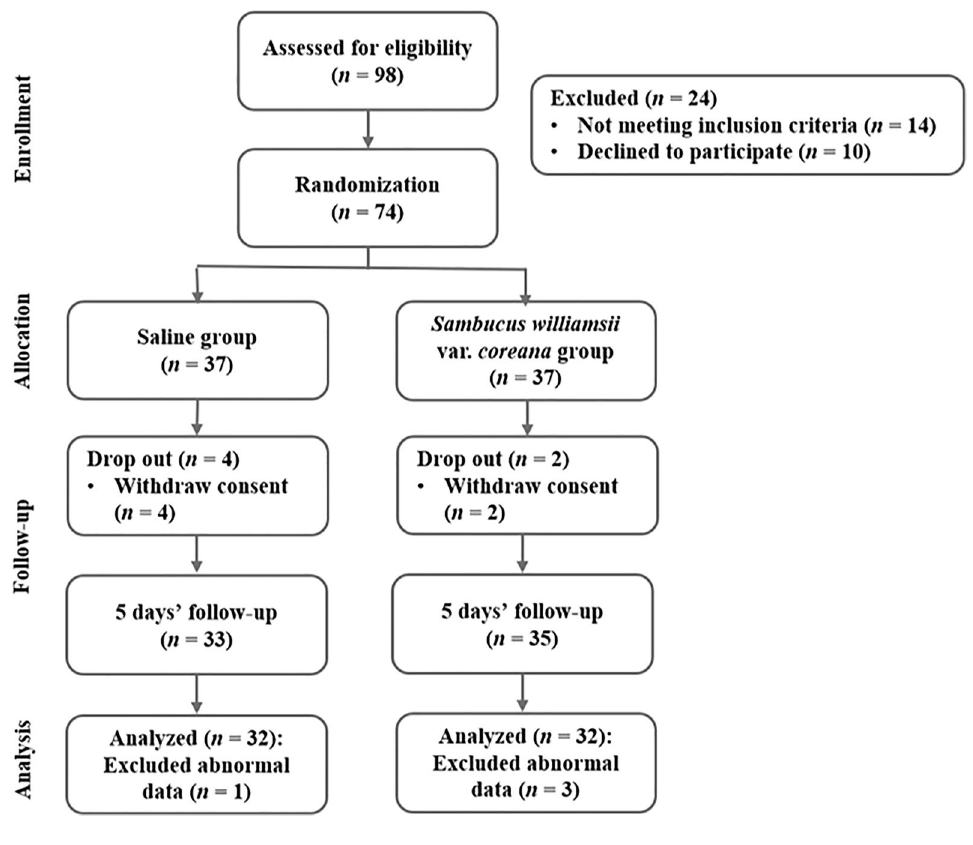
Figure 1. Flowchart of the